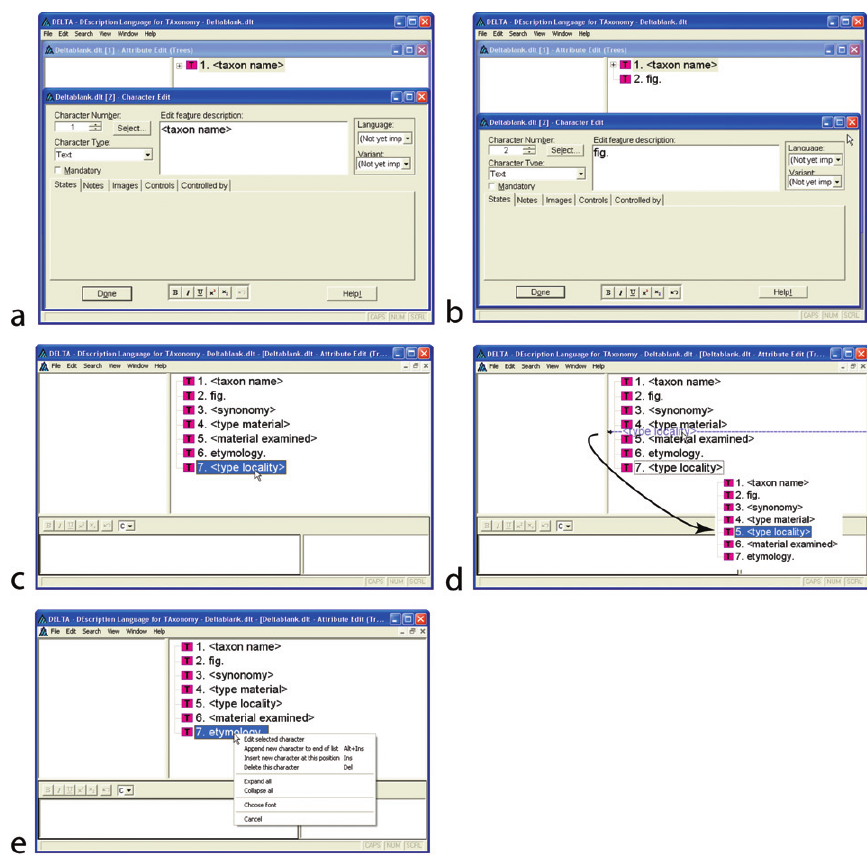
Figure 6a–e. Input of text characters with the Character editor and change of sequence of